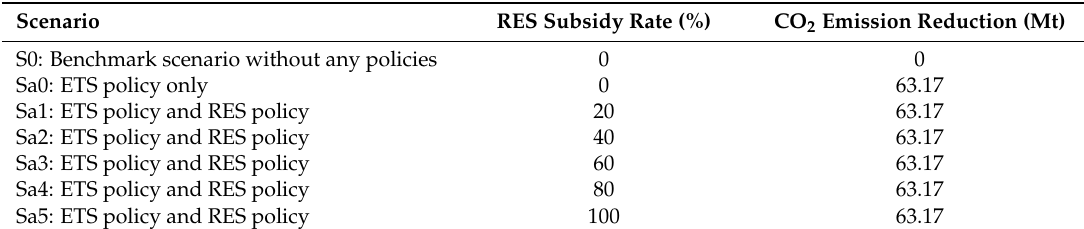
Table 3. Policy scenarios under INDC emissions reduction target of 65%.